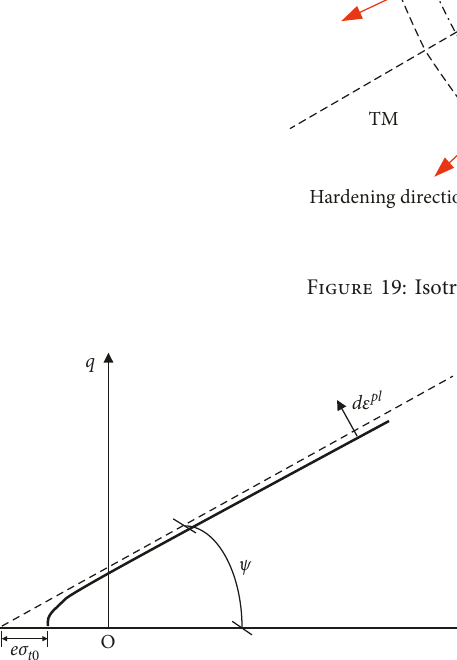
Figure 20: Hyperbolic flow potentials in the meridian plane [51].